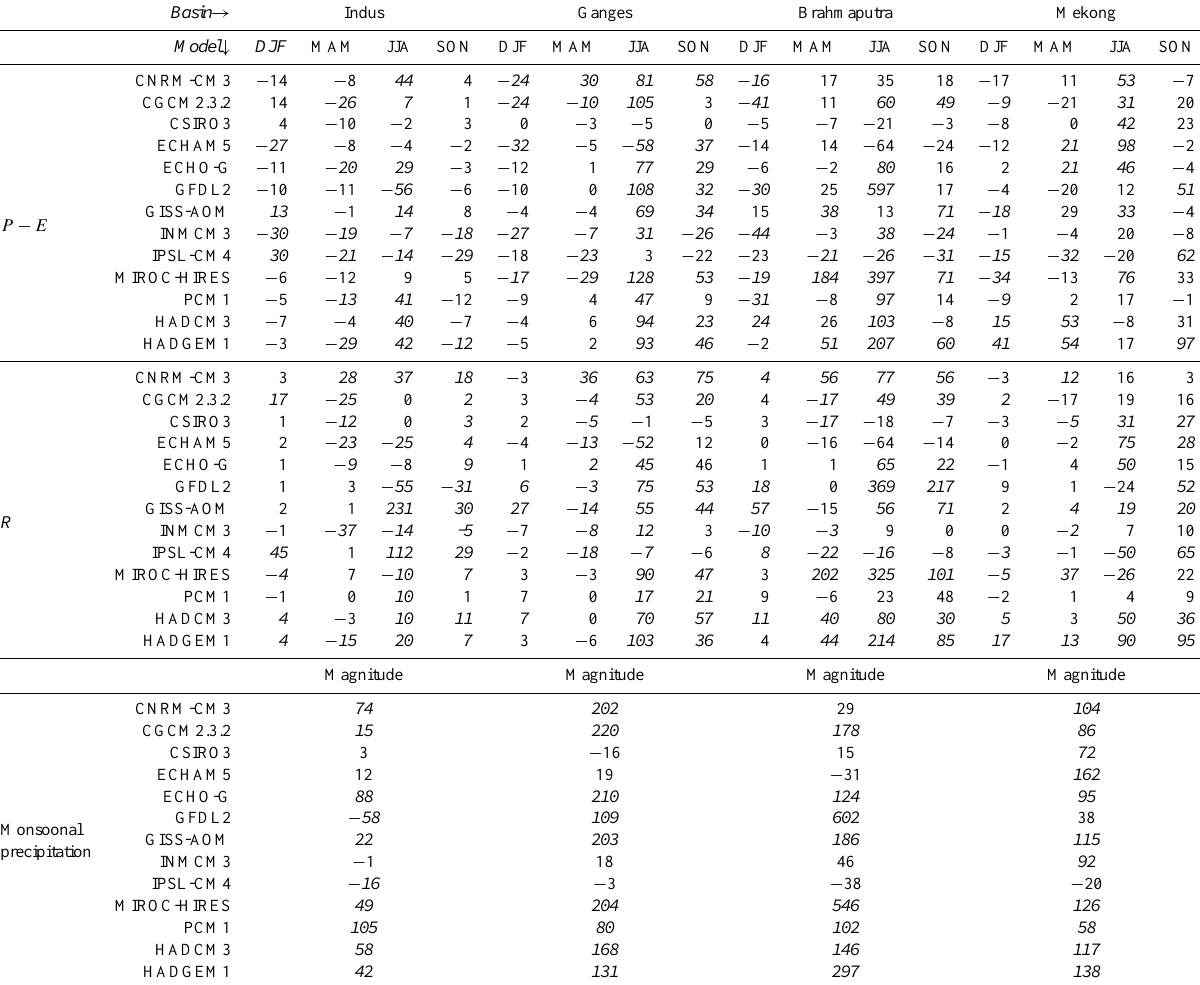
Table 2. Seasonal changes (mm) in P − E and R and changes in the magnitude of monsoonal precipitation for the 21st century climate (2061–2100) as compared to 20th century climate (1961–2000). Note that statistical significance is calculated using Student’s t test and statistically significant changes are marked as italic. Negative sign indicates decrease in quantities in mm and vice